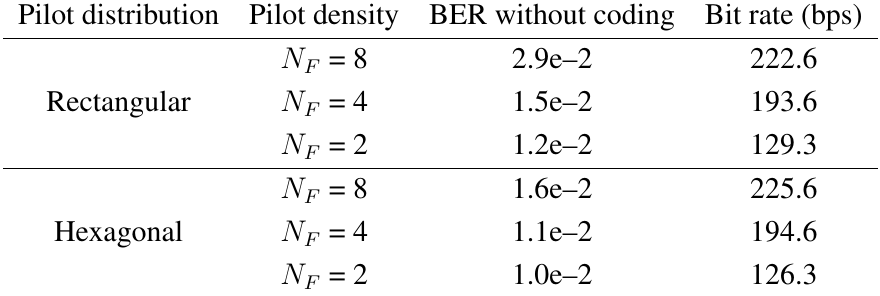
Table 2. BER and data throughput with different distribution and pilot spacing in the frequency domain. In time domain, pilot spacing was constant, N from the SAS-OE skywave link during the 2005-2006 Antarctic survey.